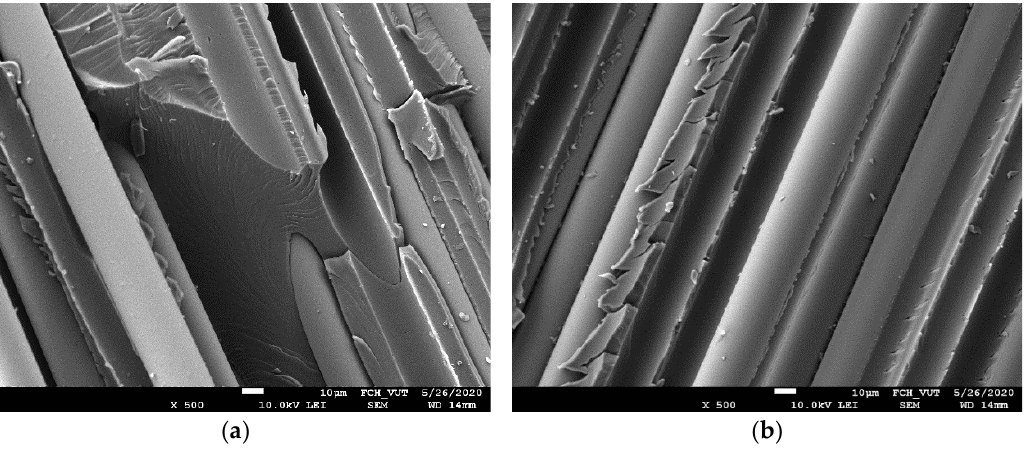
Figure 2. SEM micrograph of fractured composite beam reinforced with ( a ) fresh fibers and ( b ) glass fibers that were stored for 116 months.